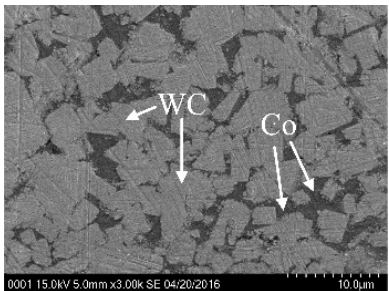
Figure 1. Cemented carbide workpiece.